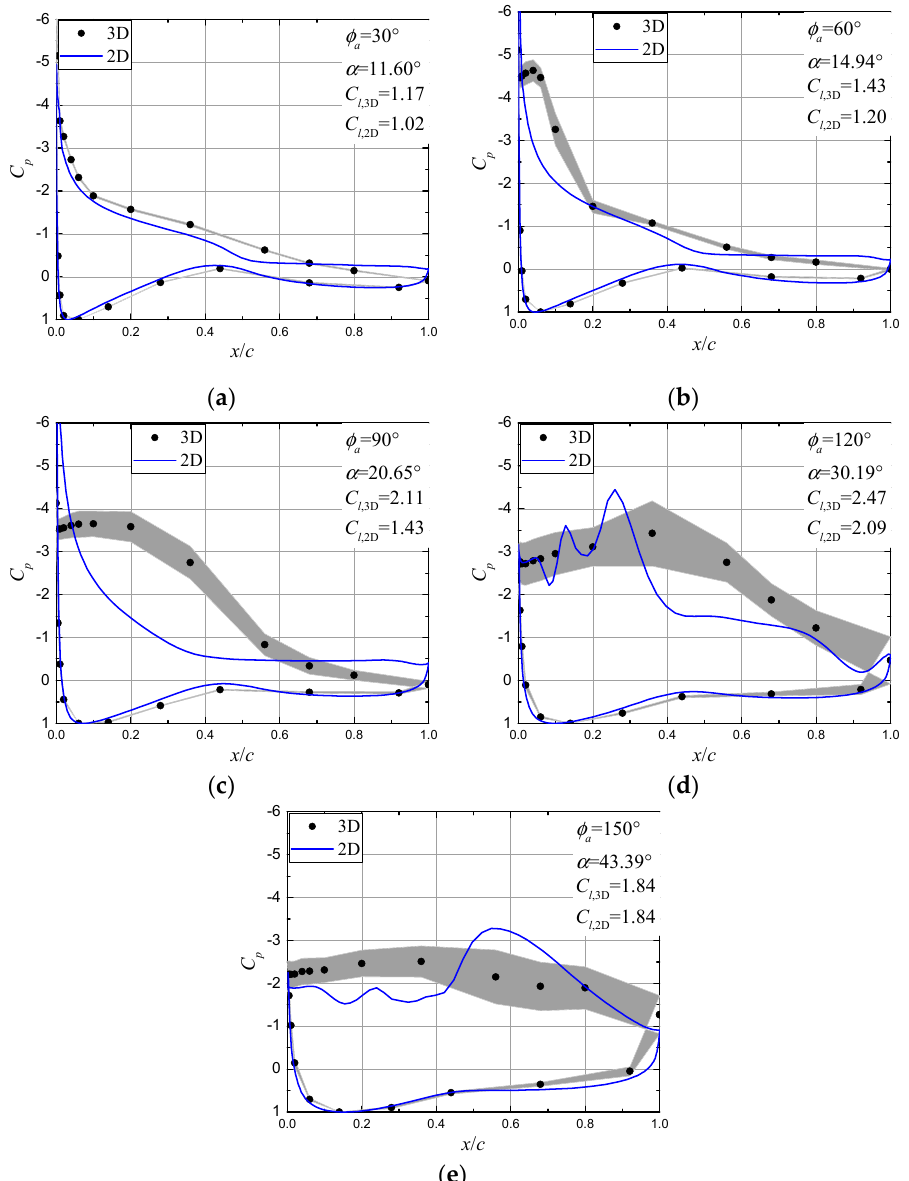
Figure 12. Azimuthal variation of the pressure distributions on the upwind side of rotor plane. r / R = 30%, V w = 15 m / s, and φ y = 30 ◦ . 3D data are mean ± SD. ( a ) φ a = 30 ◦ ; ( b ) φ a = 60 ◦ ; ( c ) φ a = 90 ◦ ; ( d ) φ a = 120 ◦ ; ( e ) φ a = 150 ◦ .